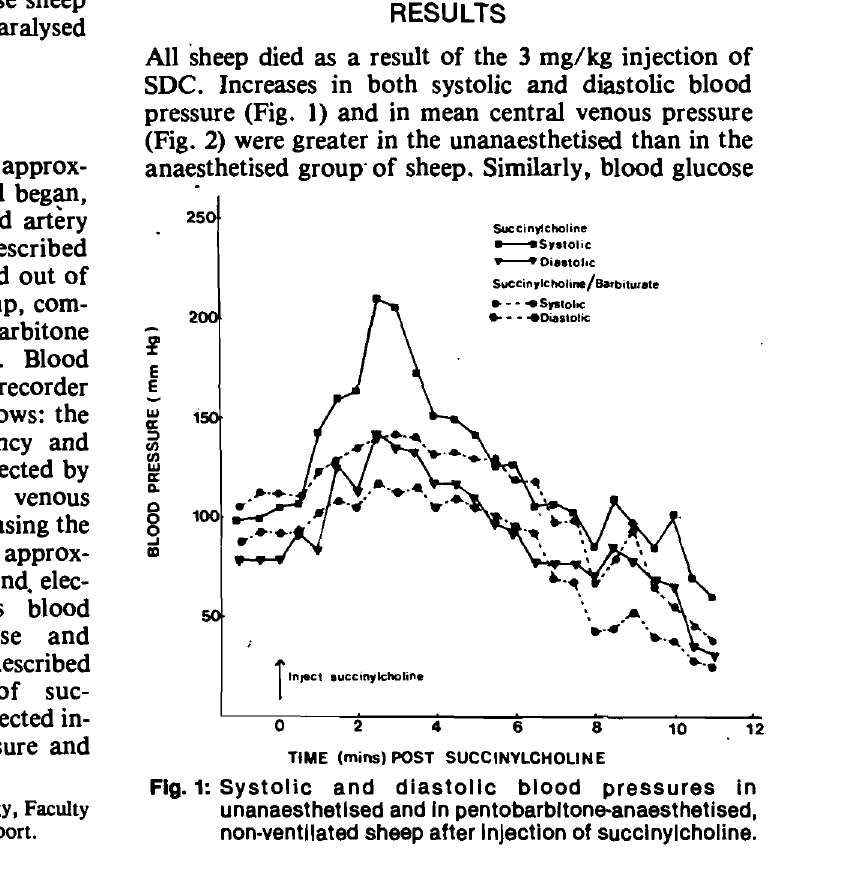
Fig. 1: SystoliC and diastolic blood pressures in unanaesthetlsed and In pentobarbitone-anaesthetised, non-ventilated sheep after Injection of